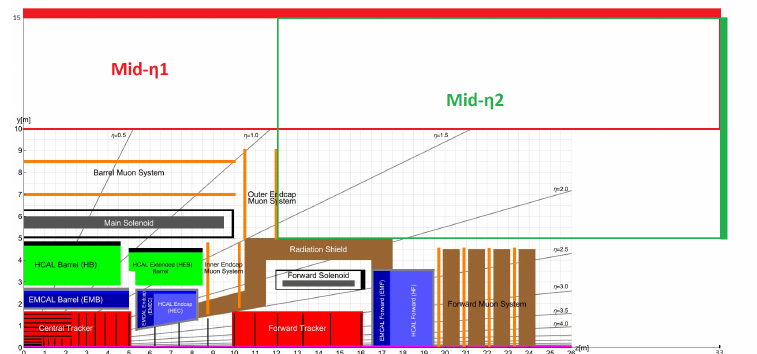
Figure 7 . Schematic picture of the geometry of the mid- η experiments. The red and green boxes are the decay volumes, while the thick parts represent the detectors. Only the z > 0 region is